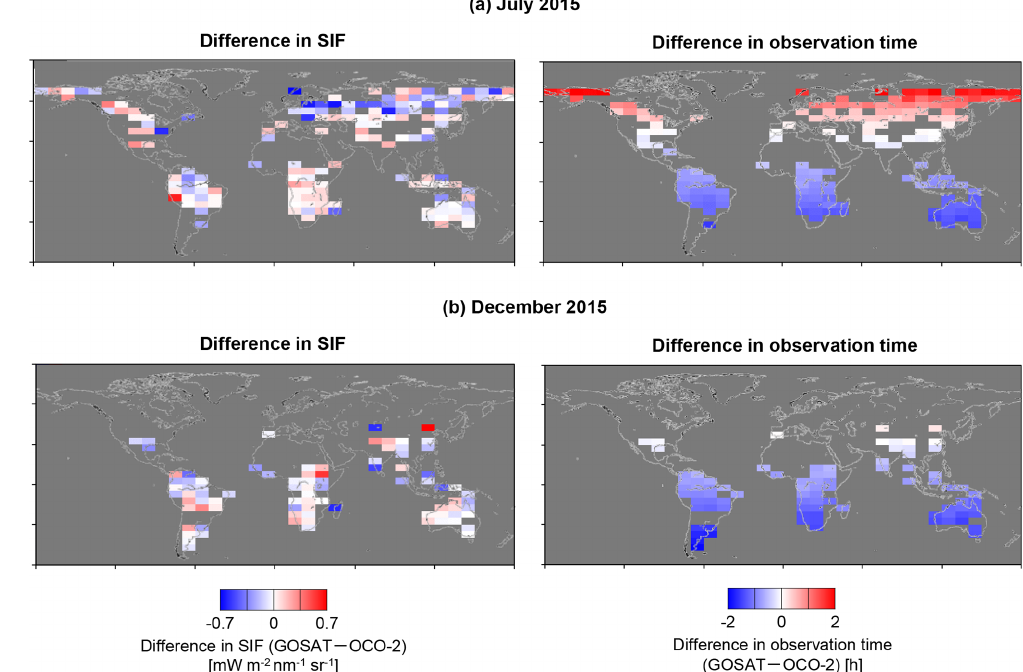
Figure 6. Difference in the monthly mean SIF (GOSAT – OCO-2) and difference in local time of the observation (GOSAT – OCO-2) within a 5 ◦ × 10 ◦ grid box: (a) July 2015; (b) December 2015. Only grids with more than nine data points are